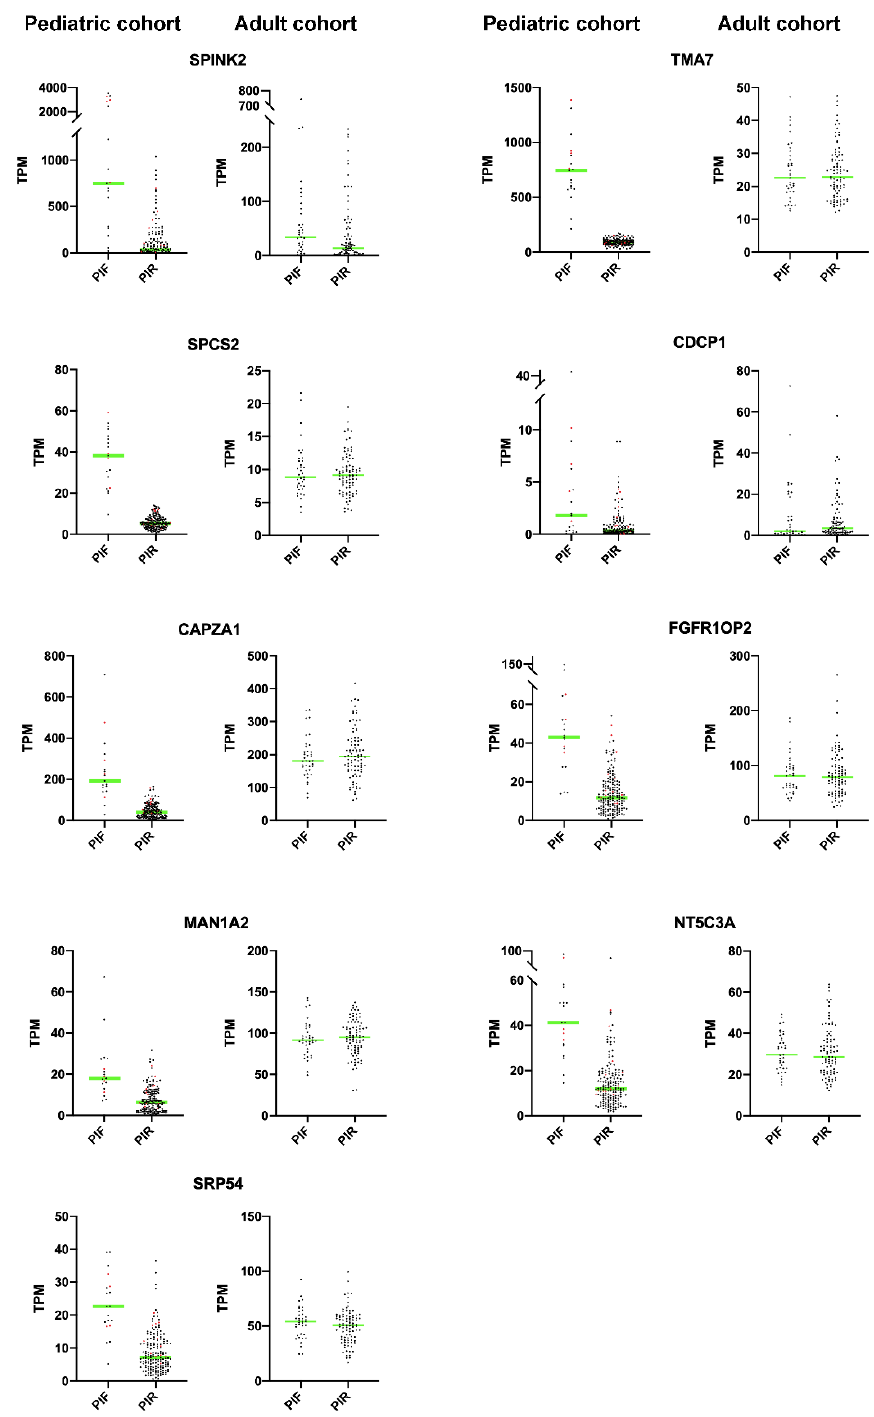
Figure 3. Dot-plots showing expression values for SPINK2, TMA7, SPCS2, CDCP1, CAPZA1, FGFR1OP2, MAN1A2, NT5C3A and SRP54 as TPM in pediatric and adult cohorts. NUP98r+ patients are showed in red dots. In adult patients a significant upregulation in PIF vs. PIR has been detected only for SPINK2 (t-test unpaired parametric p -value < 0.05); green line corresponds to mean value.